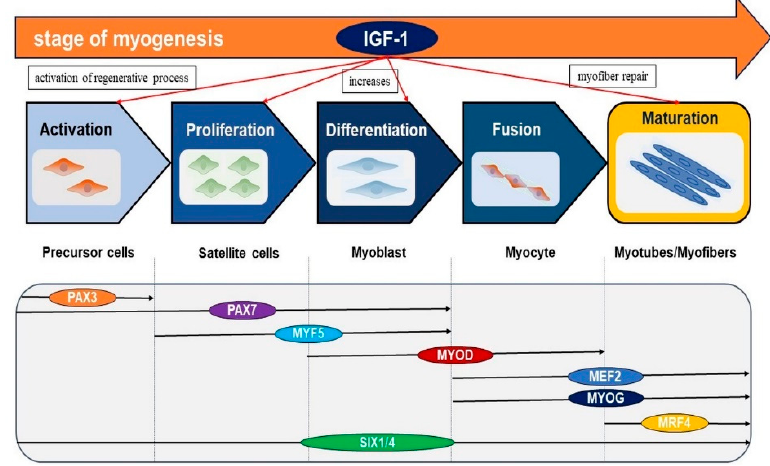
Figure 5. Role of IGF-1 in myogenesis. IGF-1 is activated during muscle regeneration and increases MSC proliferation and differentiation. In addition, IGF-1 promotes myofiber repairs.